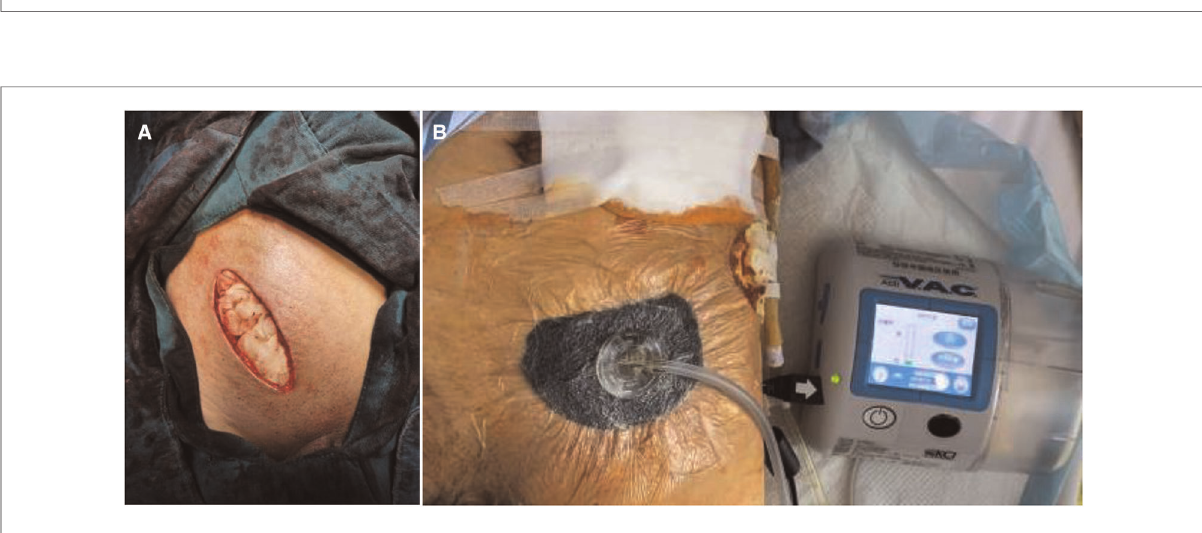
FIGURE 5 ( A ) the wound was fi lled with gauze when operation ended; ( B ) the negative pressure wound therapy was